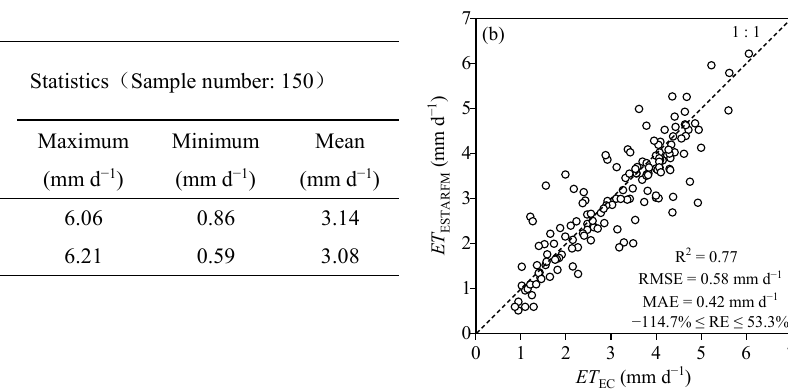
Figure 5. Comparisons of ET EC measured by an eddy covariance system and ET ESTARFM fused by ESTARFM in cotton fields under film-mulched drip irrigation at the Wulanwusu Agricultural Experimental Station in 2012: ( a ) Table for the statistical characteristics of measured ET EC and fused ET ESTARFM ; and ( b ) 1:1 diagram (R 2 : coefficient of determination; RMSE: root-mean-square error; RE: relative error; MAE: mean absolute error).